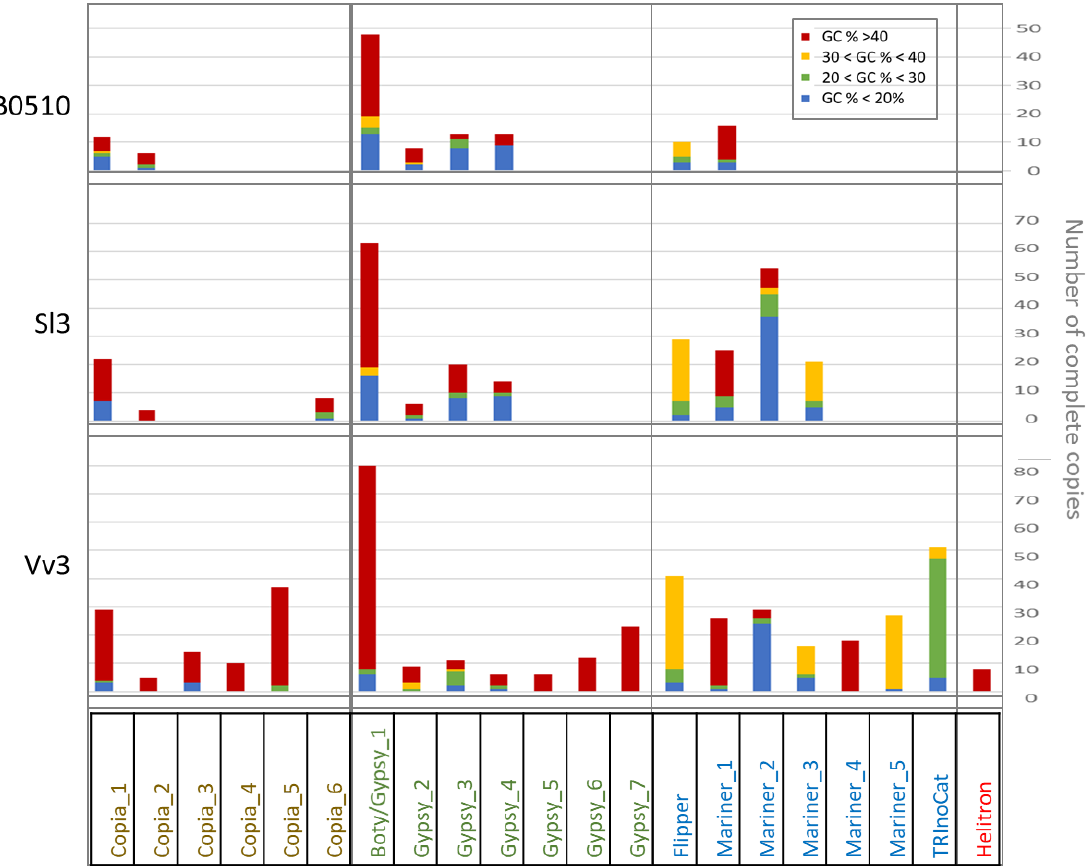
Figure 3: GC content of complete copies of the main Transposable Elements (TEs) in the genomes of B. cinerea strains B05.10, Sl3 and Vv3. The complete copies of each subfamily of TEs were classified according to their GC content. See Sup. Fig. S11 for more